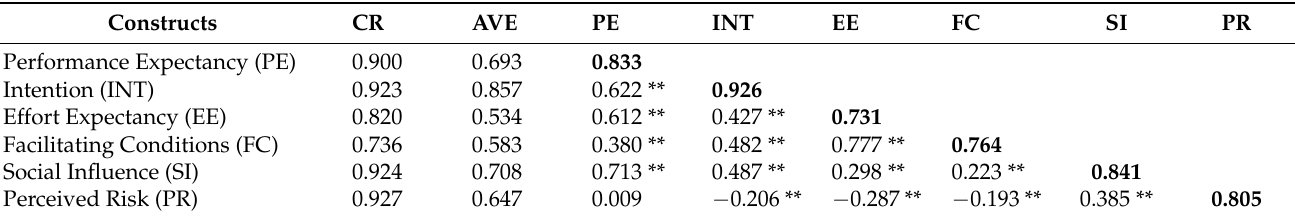
Table 2. Reliability and validity measures of latent